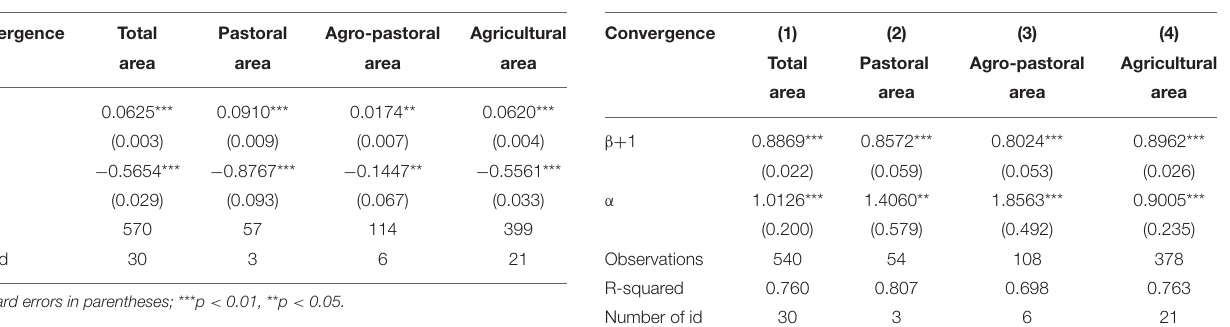
TABLE 4 | Absolute β convergence result. TABLE 5 | Conditional β convergence